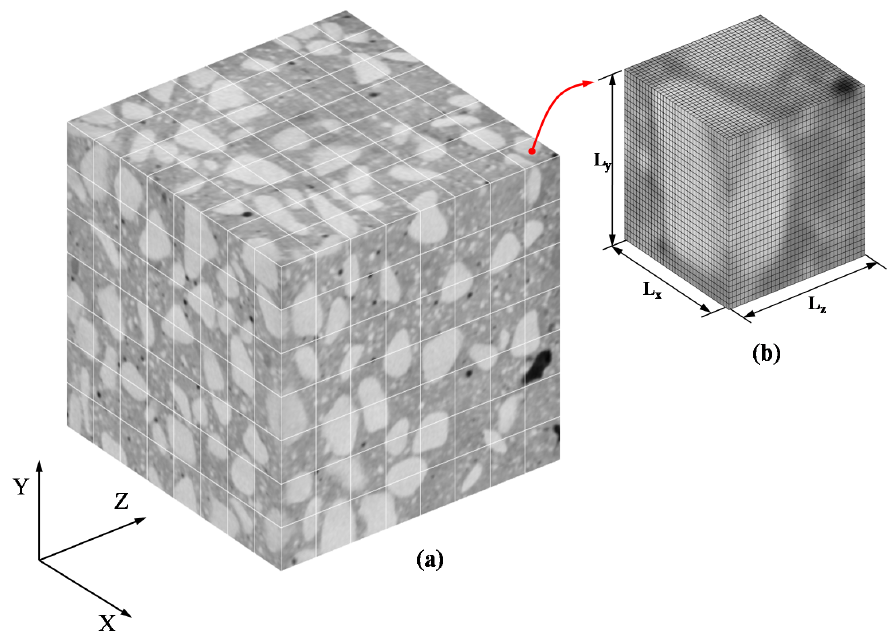
Figure 3. ( a ) Schematic of 3D moving window technique on a cubic concrete specimen reconstructed using 2D CT images, ( b ) Detail of the voxel based finite element (FE) mesh of a specific statistical volume element (SVE) model of dimensions L x × L y × L z